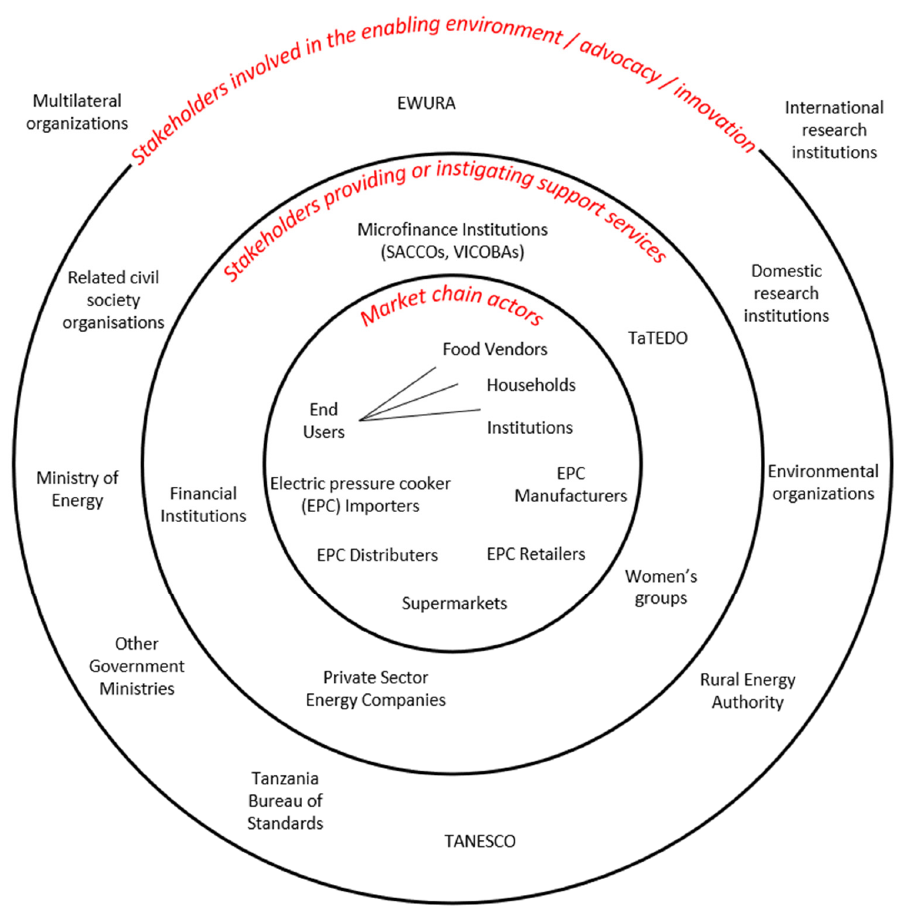
Figure 3. Map of stakeholders in the eCooking Market System. Acronyms: EWURA—Energy and Water Utilities Regulatory Authority; SACCO—Savings and Credits Cooperative Society; VICOBA—Village Community Bank; TANESCO—Tanzania Electric Supply Company Ltd.